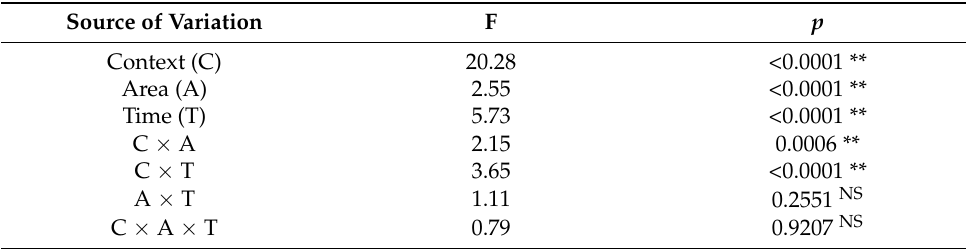
Table 1. MANOVA tests.